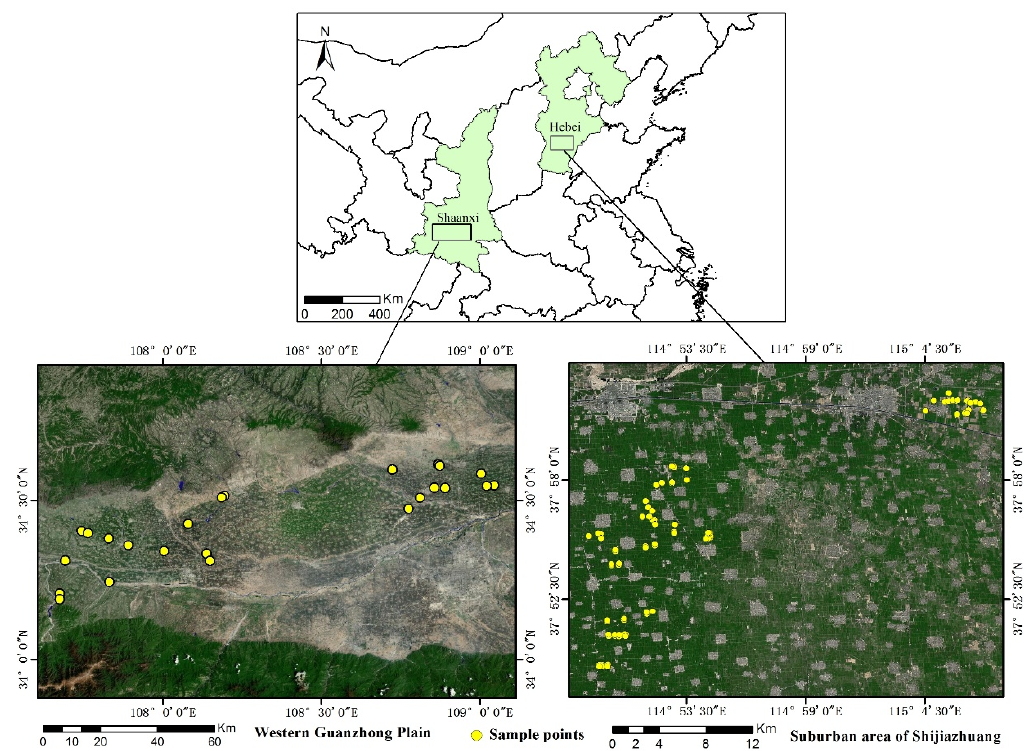
Figure 1. The location and sampling sites of the two areas: Western Guanzhong Plain ( left ) and suburban farmlands of Shijiazhuang ( right ). Yellow dots indicate locations that were sampled for wheat powdery mildew.